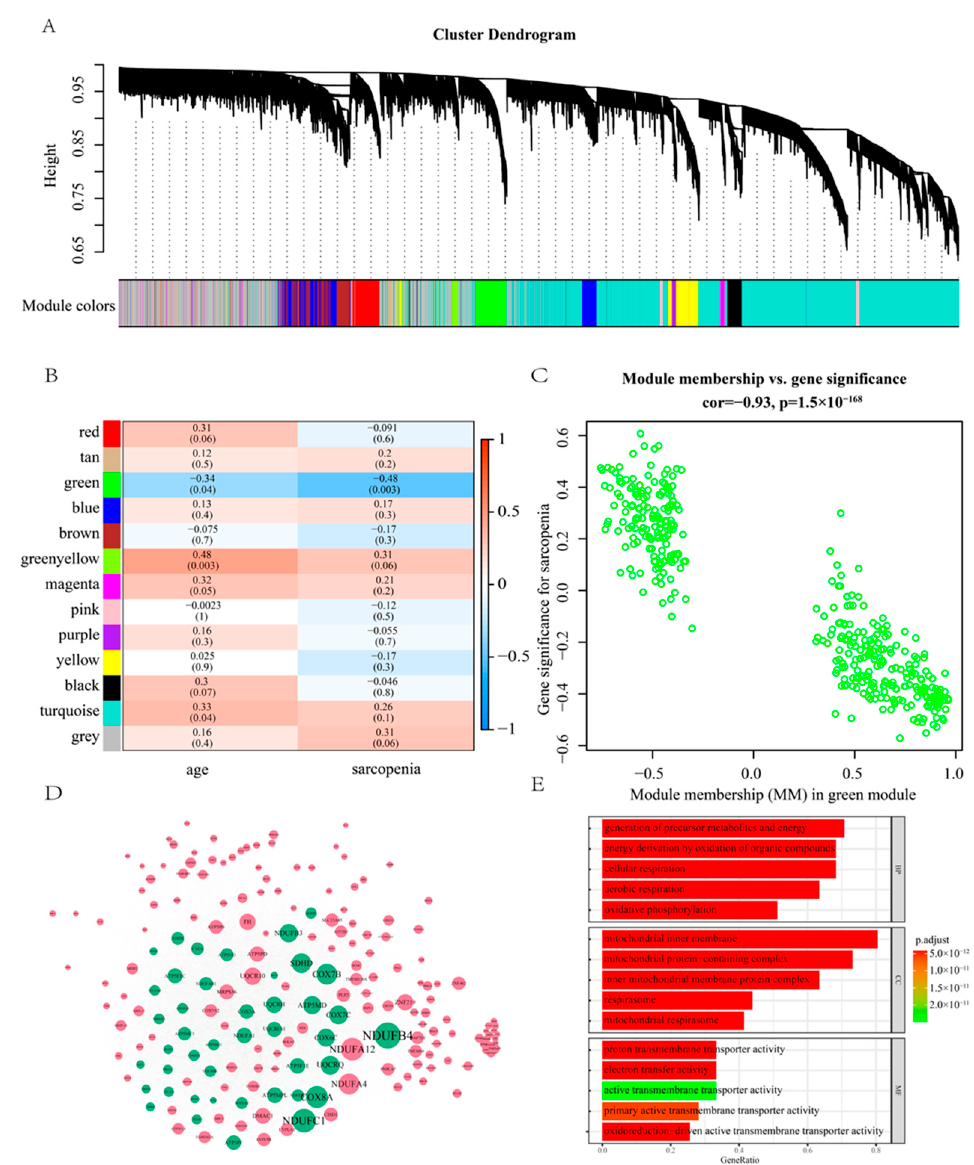
Figure 4. ( A ) Cluster dendrogram of the 39 samples in GSE111016. ( B ) Heatmap of the correlation between the module eigengenes and phenotype. ( C ) Visualization of gene significance (GS) vs. module membership (MM) and gene expression levels of the green module. ( D ) Co-expression network of the green module. The green dots represent the significantly differentially expressed genes. The size of the dots stands for the absolute value of the log fold change. ( E ) Gene Ontology enrichment analysis of the 43 significant genes (Section 2.4).